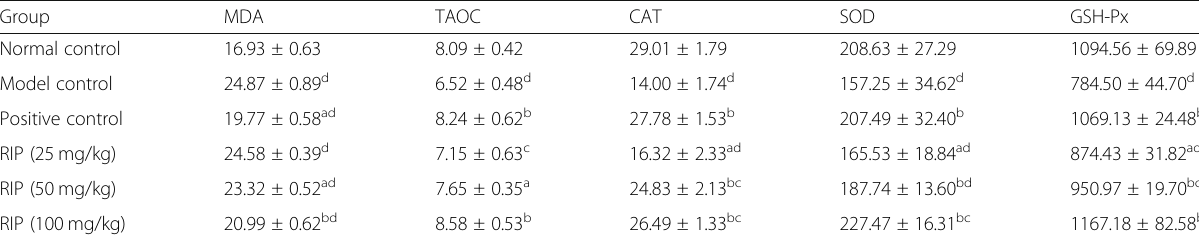
Table 4 Effects of different treatments on the activities of CAT (U/ml), SOD(U/ml), GSH-Px (U/ml) and levels of MDA (nmol/ml) and TAOC (U/ml) in the serum of aging mice Group